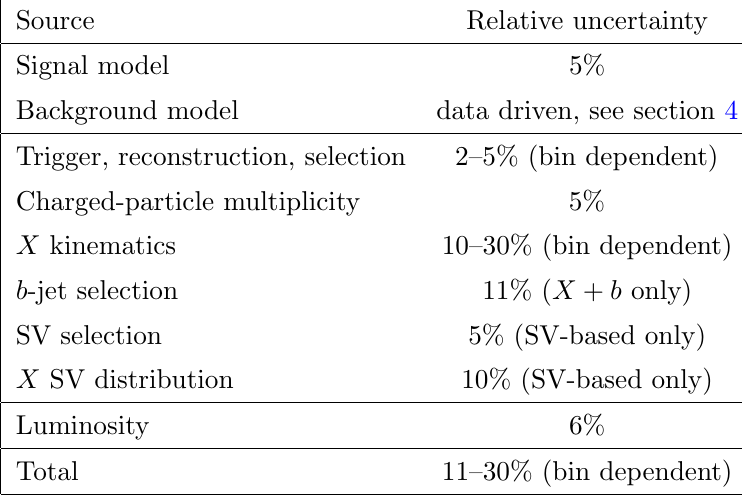
(cid:22) + (cid:22) (cid:0) ) in the !